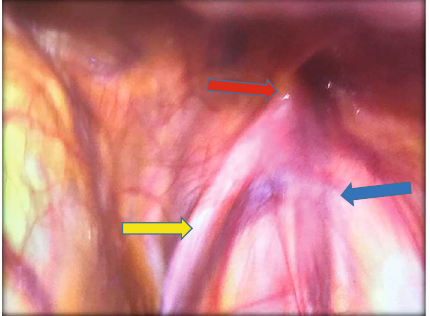
Figure 3: Laparoscopic view of the spermatic vessels (blue arrow) and vas deferens (yellow arrow) exiting the right “ open ” deep inguinal ring (red arrow).